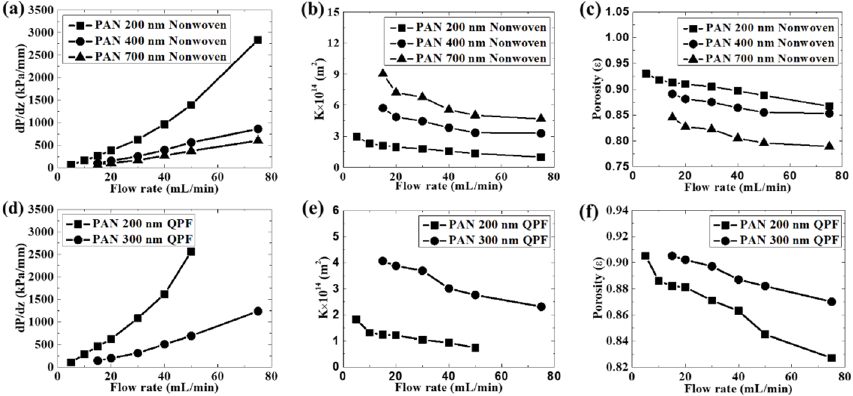
Figure 4. For nonwoven random fibrous membranes with various fiber diameters, the influence of the hydraulic flow on ( a ) hydraulic pressure drop, ( b ) permeability constant, and ( c ) porosity. For QPF membranes with various fiber diameters, the influence of the hydraulic flow on ( d ) hydraulic pressure drop, ( e ) permeability constant, and ( f )